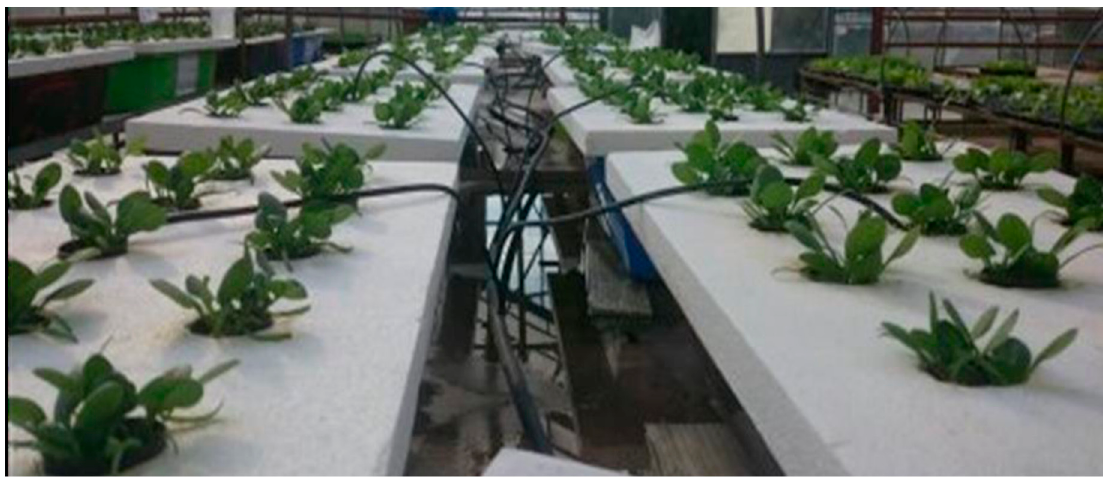
Figure 1. The layout of the experiment in the greenhouse.